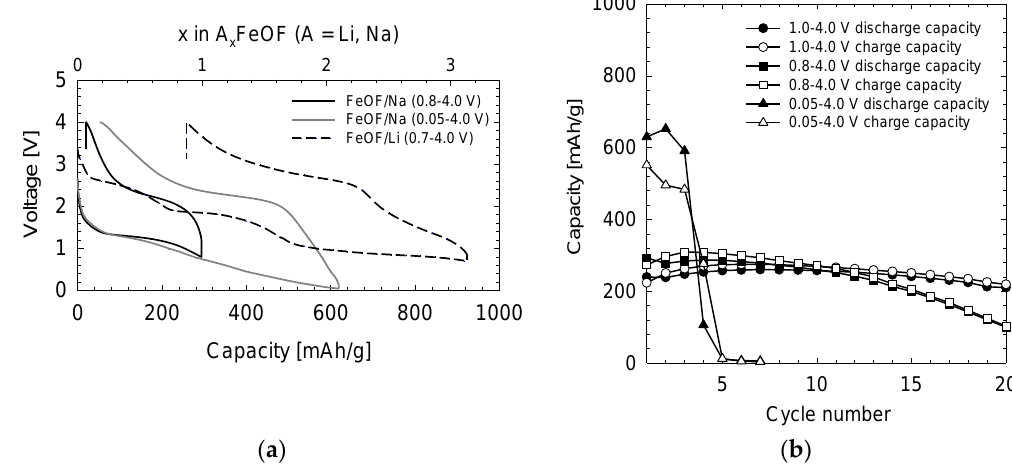
Figure 1. ( a ) Typical first and second discharge/charge curves of iron oxyfluoride (FeOF) electrodes versus Na metal in the voltage ranges of 0.8–4.0 V (gray solid line), 0.05–4.0 V (black solid line), and 1.0–4.0 V versus Li metal (broken line). ( b ) Cycling performance of FeOF electrodes versus Na metal in different voltage ranges.